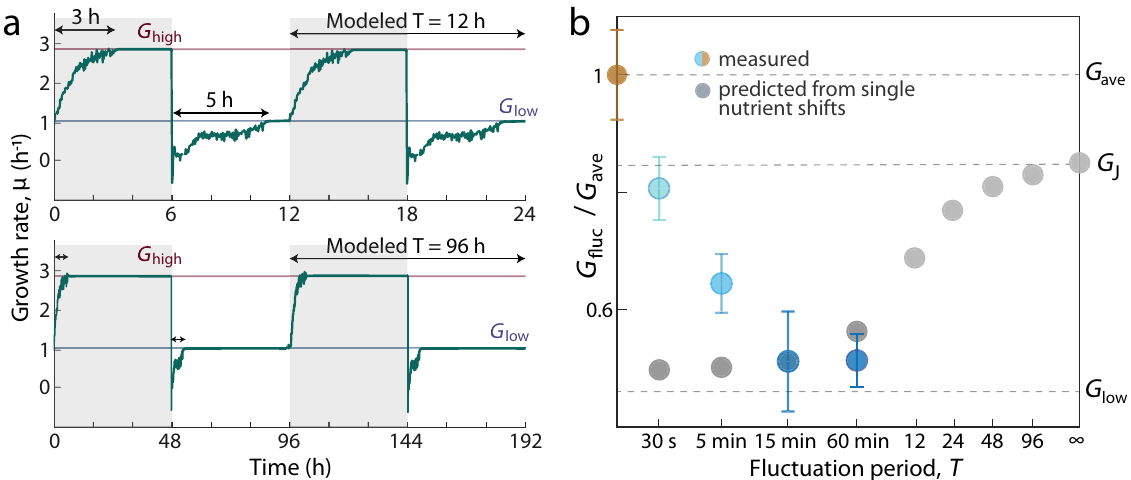
Fig. 6 Growth rate under rapid nutrient fl uctuations is sensitive to timescale and higher than predicted by a null model based on single shifts. a Instantaneous growth rate dynamics modeled using growth rate responses measured from single nutrient shifts. The dynamics modeled for two slow nutrient timescales ( T = 12 and 96 h) are illustrated here. At these timescales, each phase of C high or C low is substantially longer than the 3 or 5 h required for cells to reach either steady-state G high or G low after a single up- or downshift, respectively. The models used for growth rate dynamics at faster fl uctuation timescales are fully described in Supplementary Fig. 10a, b and Construction of Null Model in the Supplementary information. For each modeled timescale, the growth rate dynamics were time-averaged to calculate the predicted average growth rates, G fl uc , plotted in ( b ). b Growth rate under rapid nutrient fl uctuation ( G fl uc , blue) is higher than predicted from data on single nutrient shifts between C high and C low . The plot shows G fl uc as a fraction of the growth rate in the steady average nutrient environment ( G ave ; gold). Each measured point represents the time-averaged growth rate G and standard deviation of the mean among replicates ( n = 3 – 4). Predicted values of G fl uc (gray) reach a maximum of G J when the fl uctuating nutrient timescale is in fi nitely long relative to the time required to transition from growth at G low to G high , and vice versa. The deviation between measured and predicted G fl uc differentiates the growth physiology at rapid fl uctuation timescales from the growth behaviors expected from single shifts, and highlights the timescale- dependent nature of the growth advantage conferred by a physiology adapted for growth under rapid nutrient fl